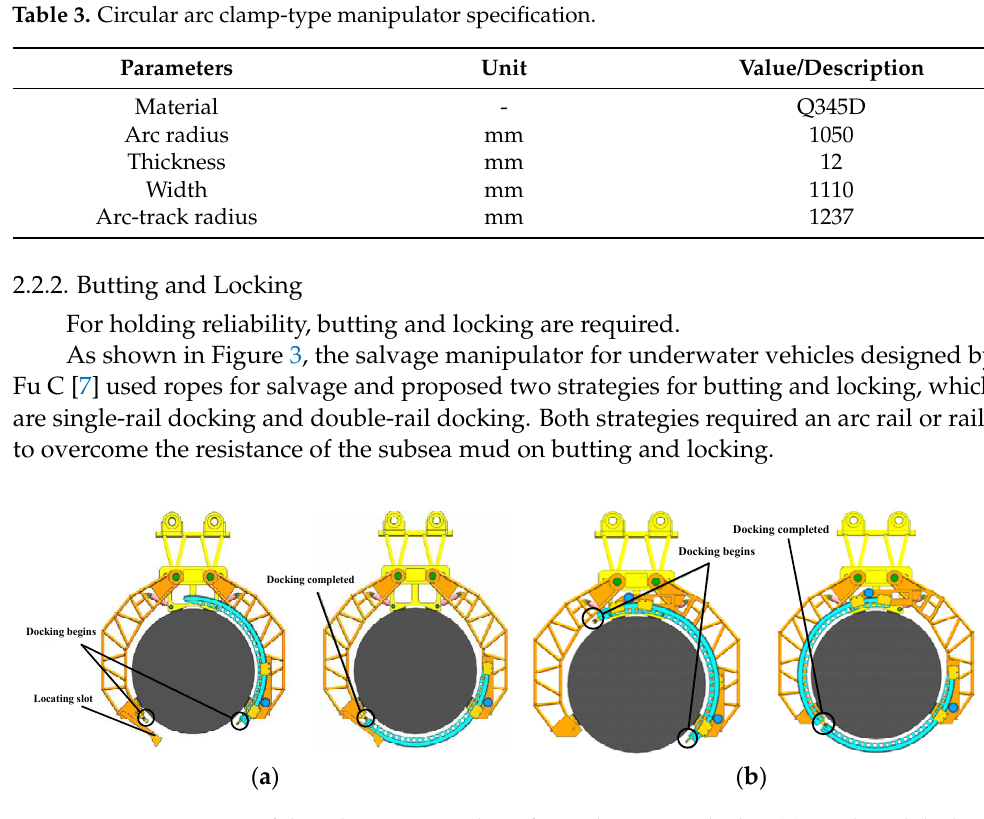
Figure 3. Two strategies of the salvage manipulator for underwater vehicles. ( a ) Single-rail dock- ing strategy and ( b ) Double-rail docking strategy. strategy and ( b ) Double-rail docking strategy.